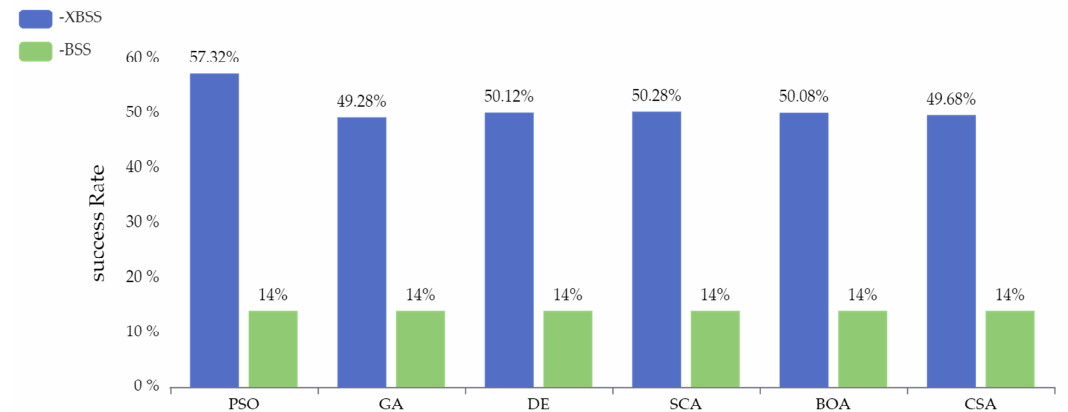
Figure 7. The success rate of separation of the six SI-XBSS and six SI-BSS algorithms. The mean values of cross-correlations of the source signals and the separated signals by SI-BSS and SI-XBSS are shown in Figure 9. The results showed that the source signals had the lowest cross correlation value—less than 20; the value by SI-XBSS was very close to that of the source signals with a range from 55.20 to 58.70; and the separated signals The mean evaluation values of the six SI-BSS and the six SI-XBSS algorithms are shown in Table 2. Compared with SI-BSS, SI-XBSS increased by 13.83 to 17.83 for SI-SDR, 0.17 to 0.19 for STOI, and 0.01 to 0.03 for PESQ. The results show that the proposed method has significantly improved the evaluation values of the three evaluation indexes.